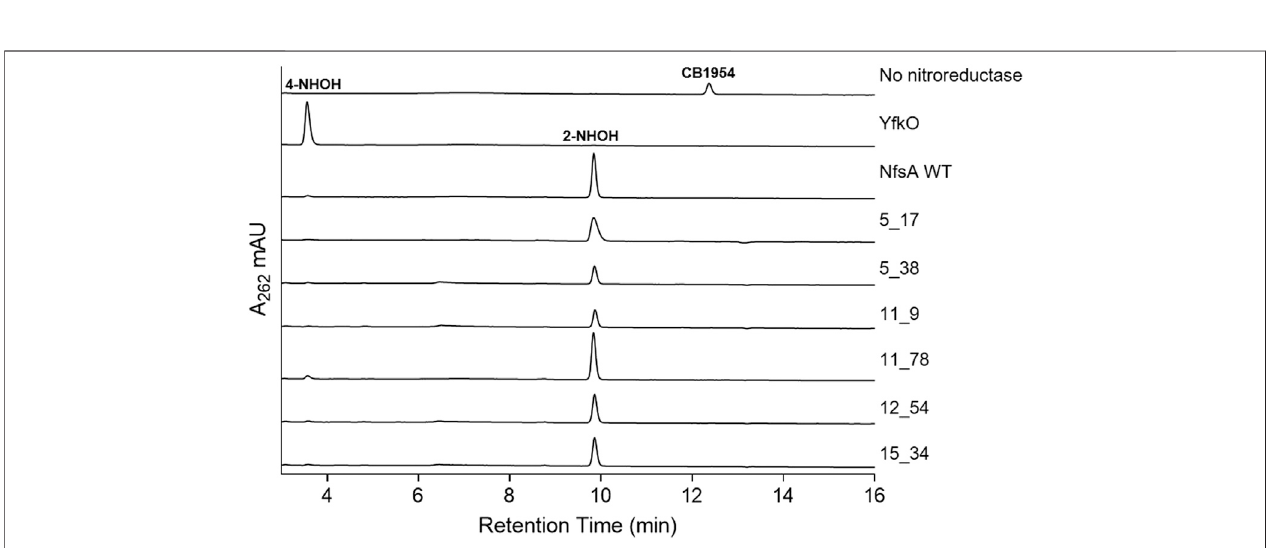
FIGURE 5 | HPLC analysis of reaction products of CB1954 reduction by puri fi ed nitroreductases. Puri fi ed His 6 -tagged nitroreductases were incubated with CB1954 (200 µM) and NADPH (1 mM) in 10 mM Tris pH 7.0 for 25 min at room temperature prior to chromatographic separation of reaction end-products. Column eluates were monitored at 262 nm. Spectral peaks corresponding to the 4-hydroxylamine (4-NHOH) and 2-hydroxylamine (2-NHOH) end-products, or non-reduced CB1954, were determined by comparison with the YfkO, NfsA or no nitroreductase control traces, respectively.